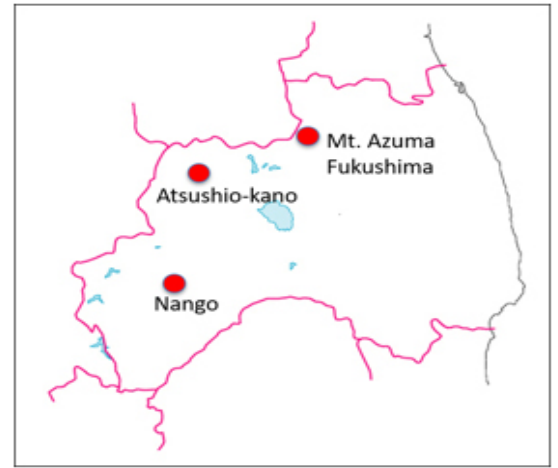
Figure 1. Collection Cities in Fuskushima